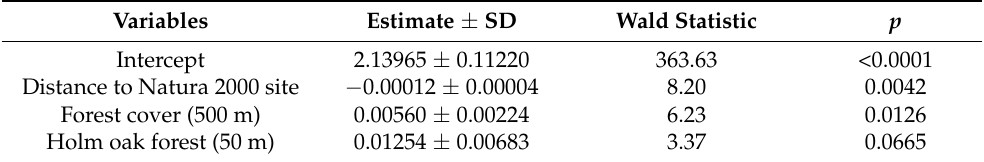
Table 3. Results of the best Poisson regression model explaining bird species richness in drove roads as a function of variables at the landscape and drove road